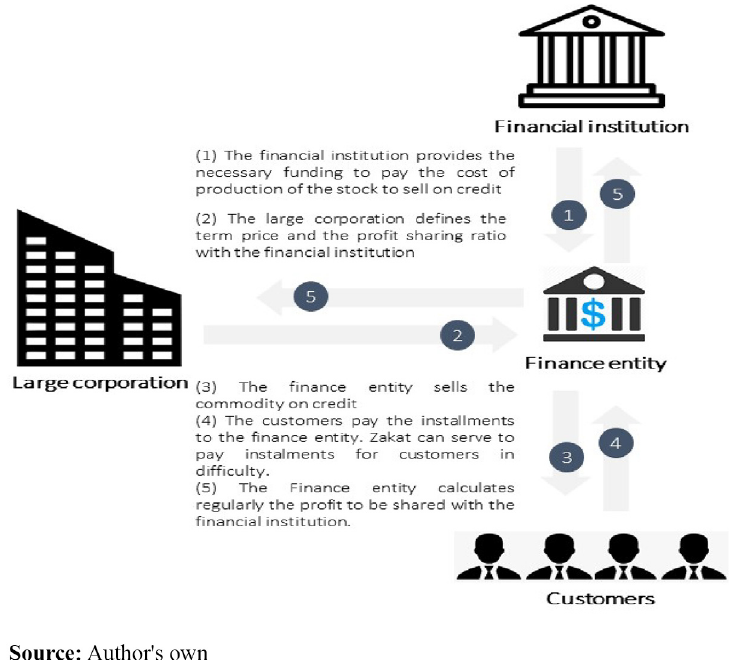
Figure 6. Selling on credit based on market